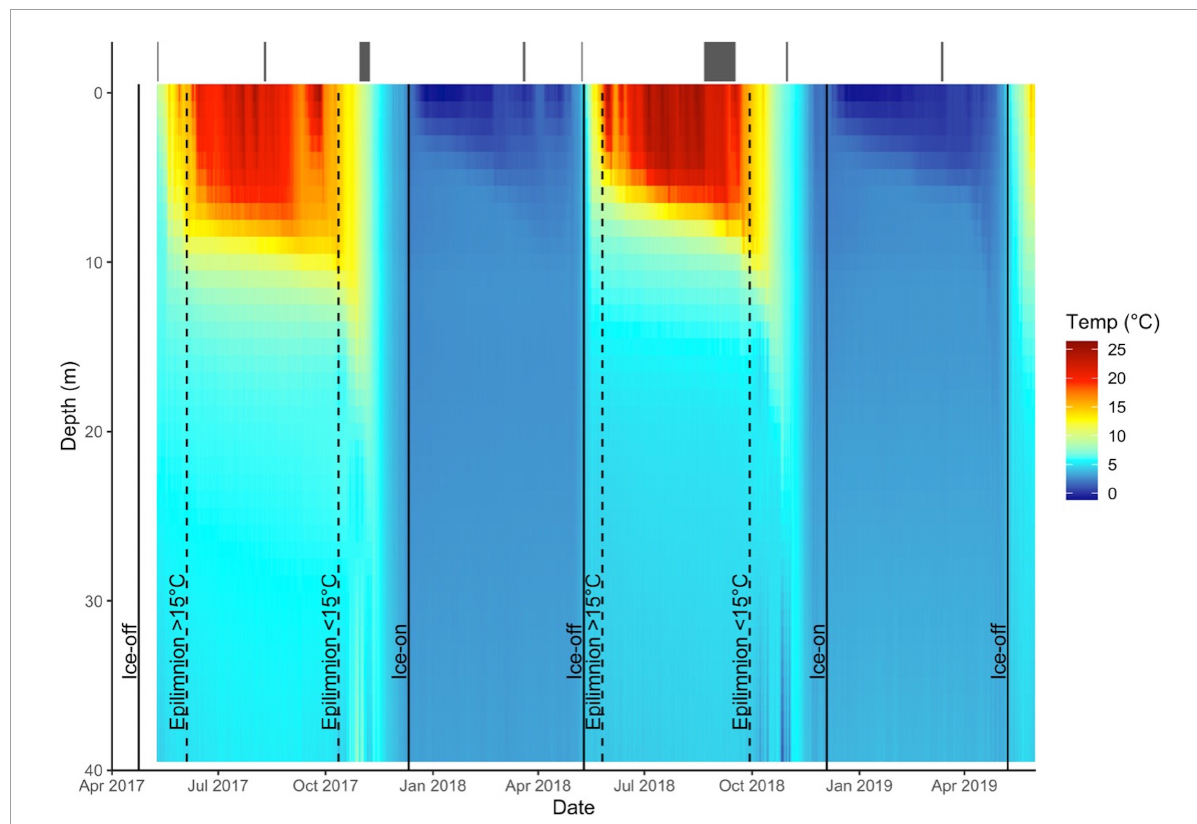
FIGURE2 Thermal profile of Lake 2 (– cisco) from May 2017 to June 2019. Solid vertical lines indicate ice-on and ice-off events and dashed vertical lines indicate epilimnion water temperatures rising above or falling below 15 ◦ C. These lines delineate seasons, with spring between ice-off and water temperature greater than 15 ◦ C, summer when water temperatures are 15 ◦ C and above, fall between water temperature less than 15 ◦ C and ice-on, and winter between ice-on and ice-off. Gray bars at the top of the plot are the sampling periods in each season, spanning from the first to last day that fish were captured for stable isotope and stomach content